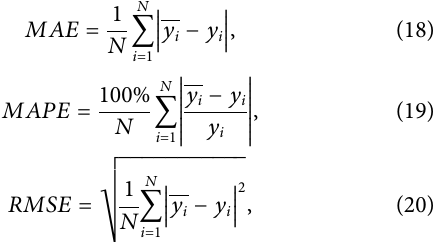
FIGURE 3 | Flowchart of probabilistic forecasting based on